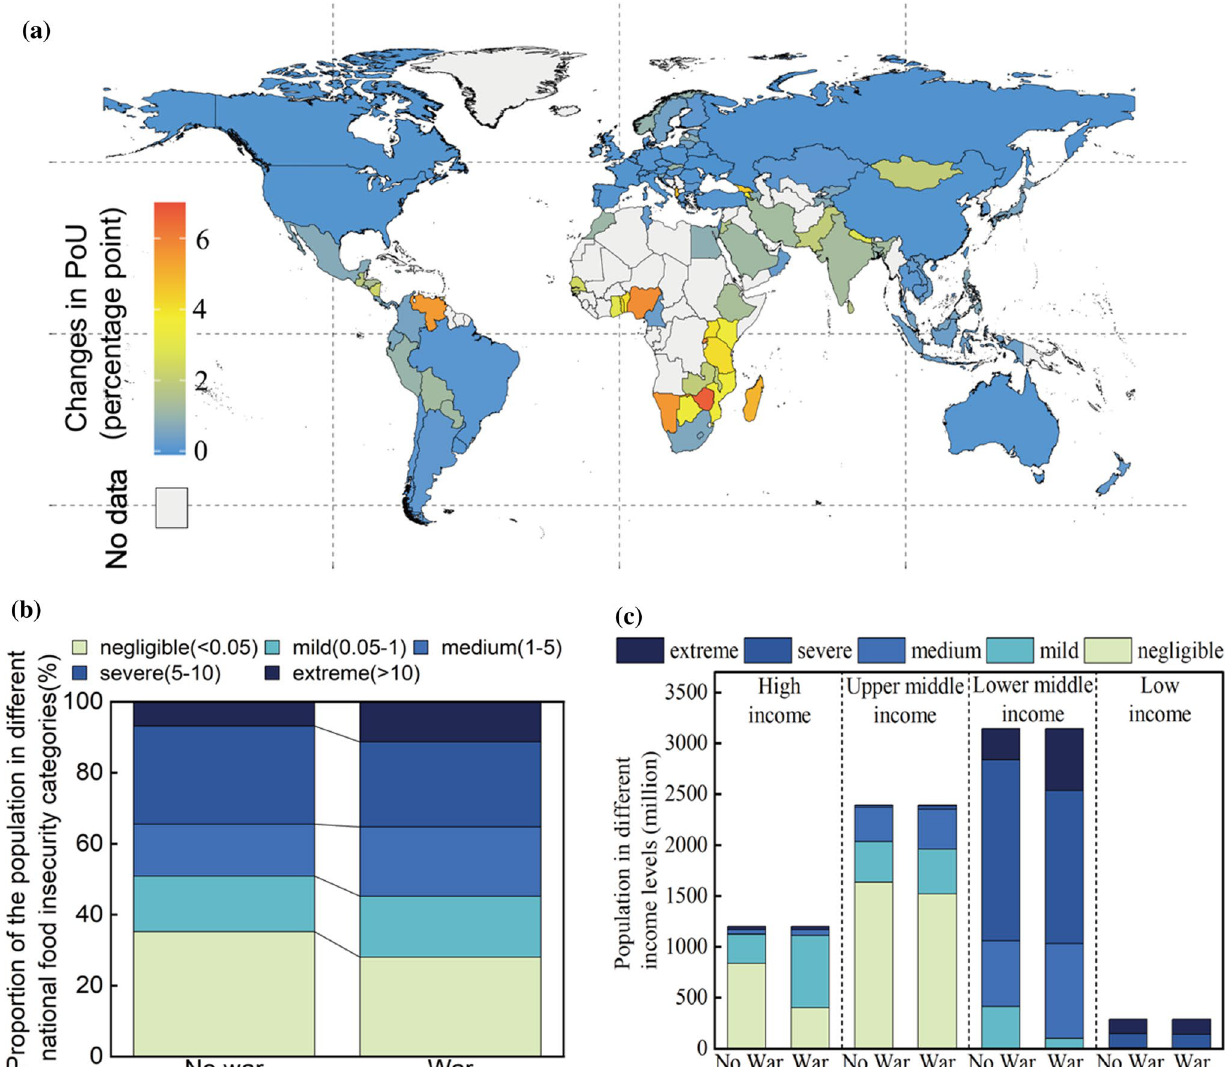
Fig. 2 Impact of the Russia–Ukraine war on the global prevalence of undernourishment (PoU) in W L S L C L T L scenario. A Changes in PoU relative to the “No-war” scenario; b changes in the proportions of the population in different national PoU categories; c the unequal impact of war on countries with different incomes. National food insecurity is categorised into five levels: negligible, mild, medium, severe, and